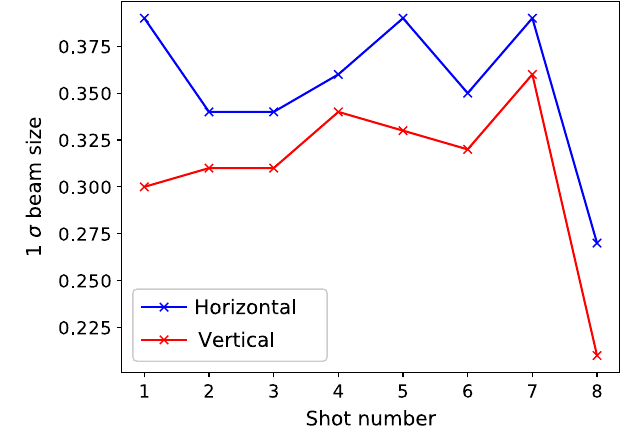
FIG. 14. Results from the collimator beam-based alignment performed at the start of the experiment.